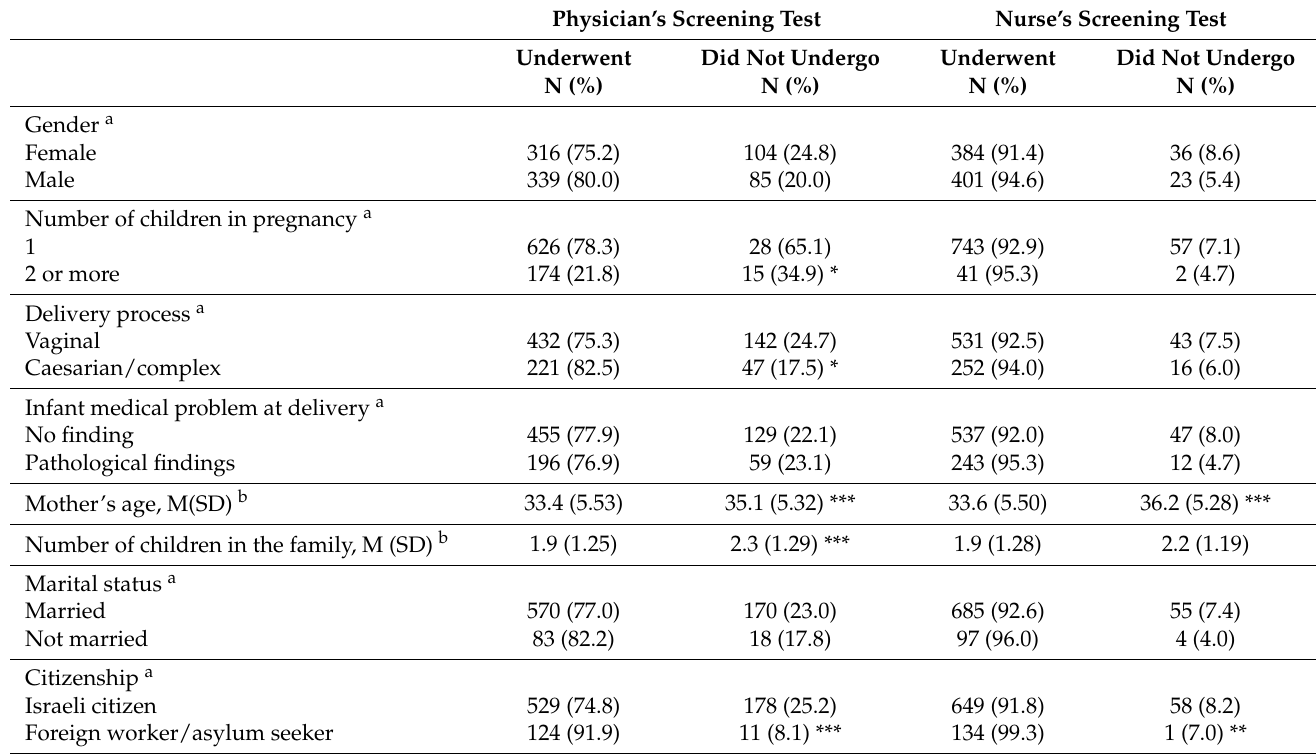
Table 3. Differences between children who did or did not undergo a physician’s or nurse’s screening test, N =